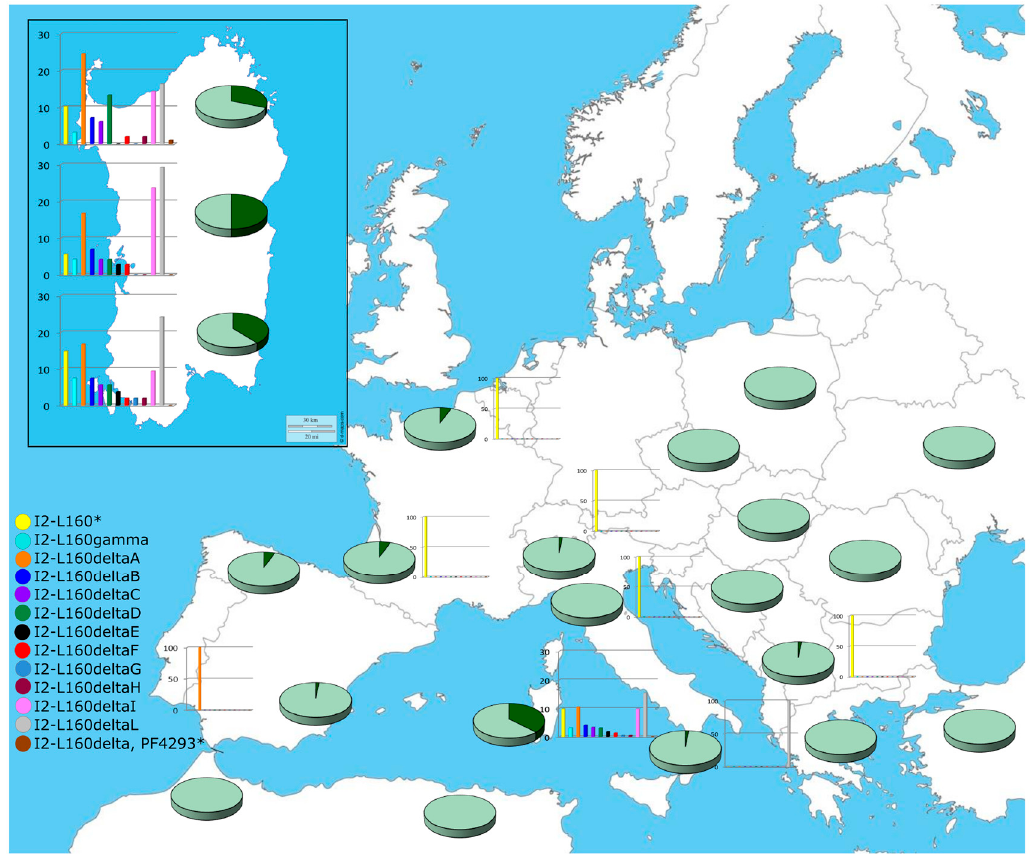
Figure 4. Geographical distribution of the Y-chromosome haplogroup I2-L160 and its sub-clades in Europe. Each pie represents a population and the dark green sector the percentage of I2-L160 (Tables S6 and S9); the histograms represent the percentages of the I2-L160 sub-clades according to the color codes shown on the figure. The inset shows the distribution of haplogroups and sub-haplogroups in the three geographical areas into which the Sardinian samples were subdivided according to the origin of their surnames.